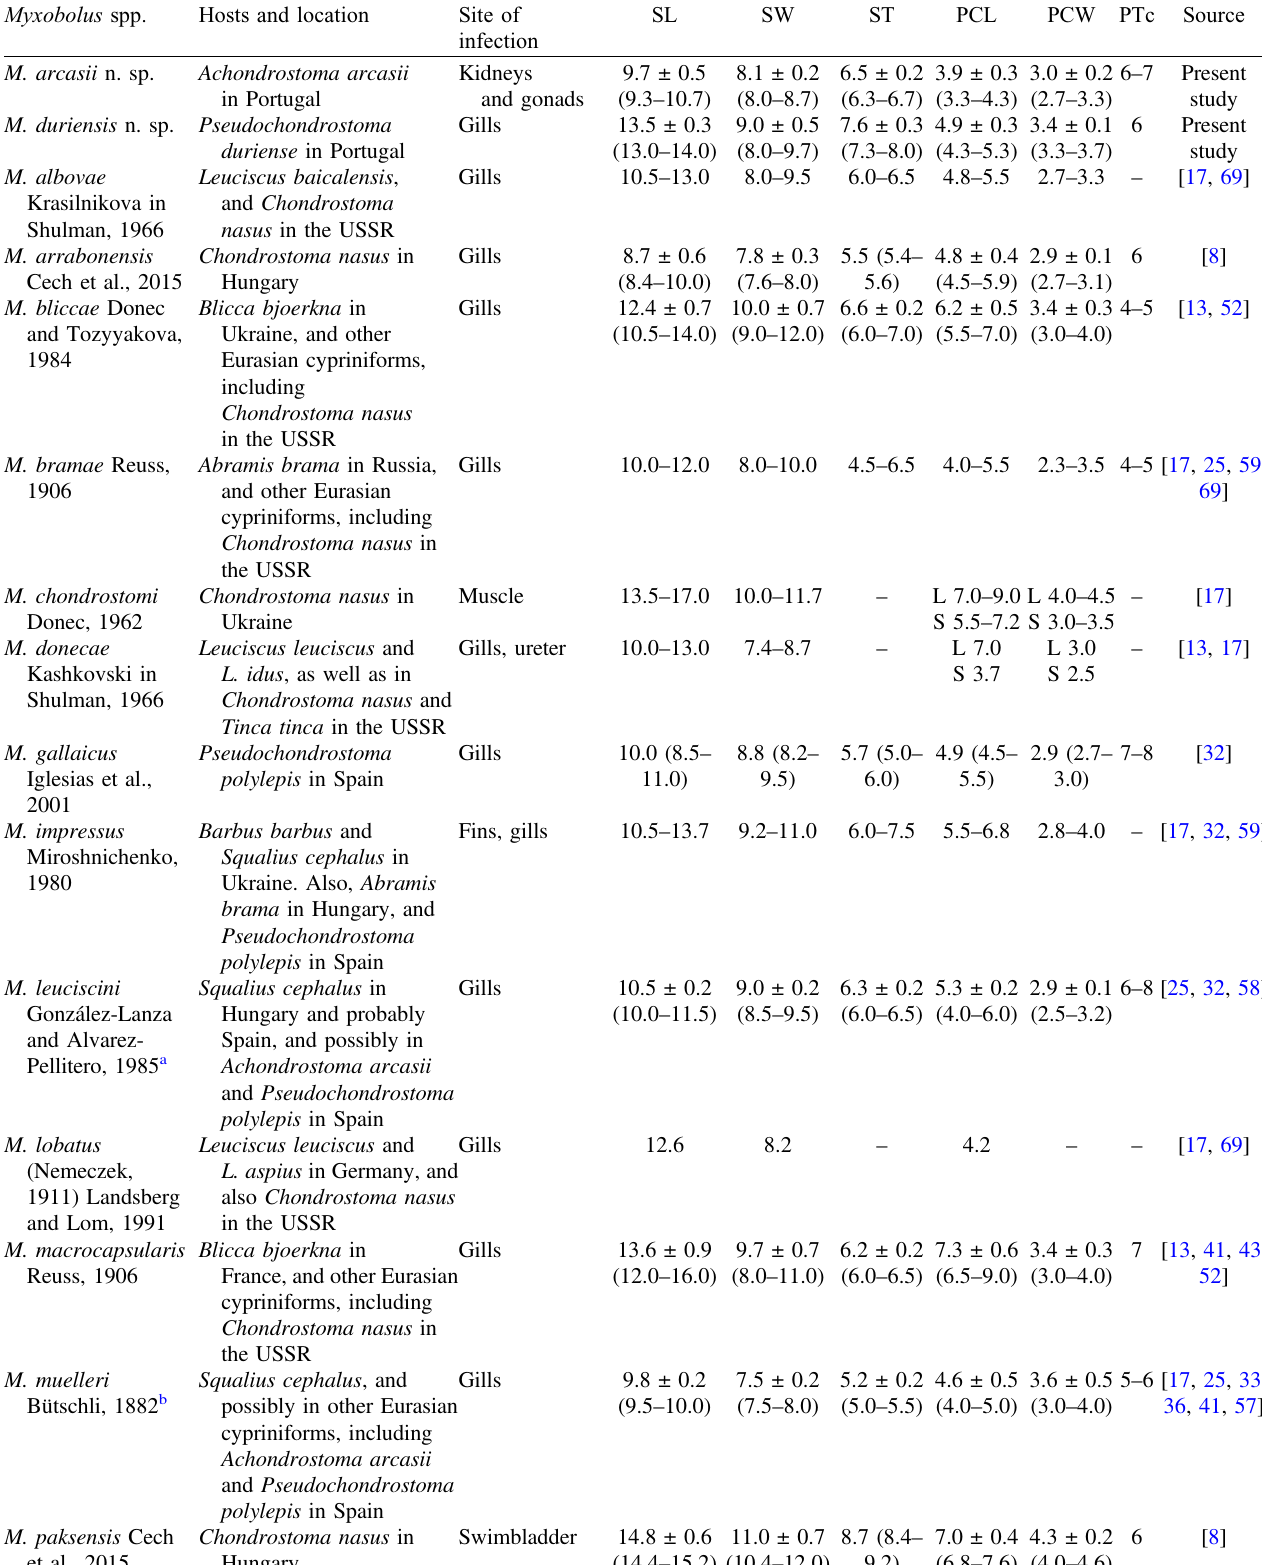
Table 2. Comparison of M. arcasii n. sp. and M. duriensis n. sp. to other Myxobolus spp. reported from fi shes belonging to closely related